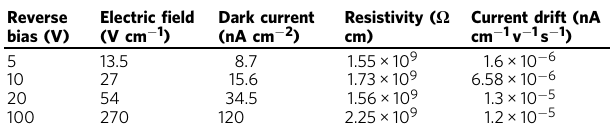
Table 2. The low noise of these high quality MAPbI 3 single crystals allows them to compete with bromine-based and low-dimension